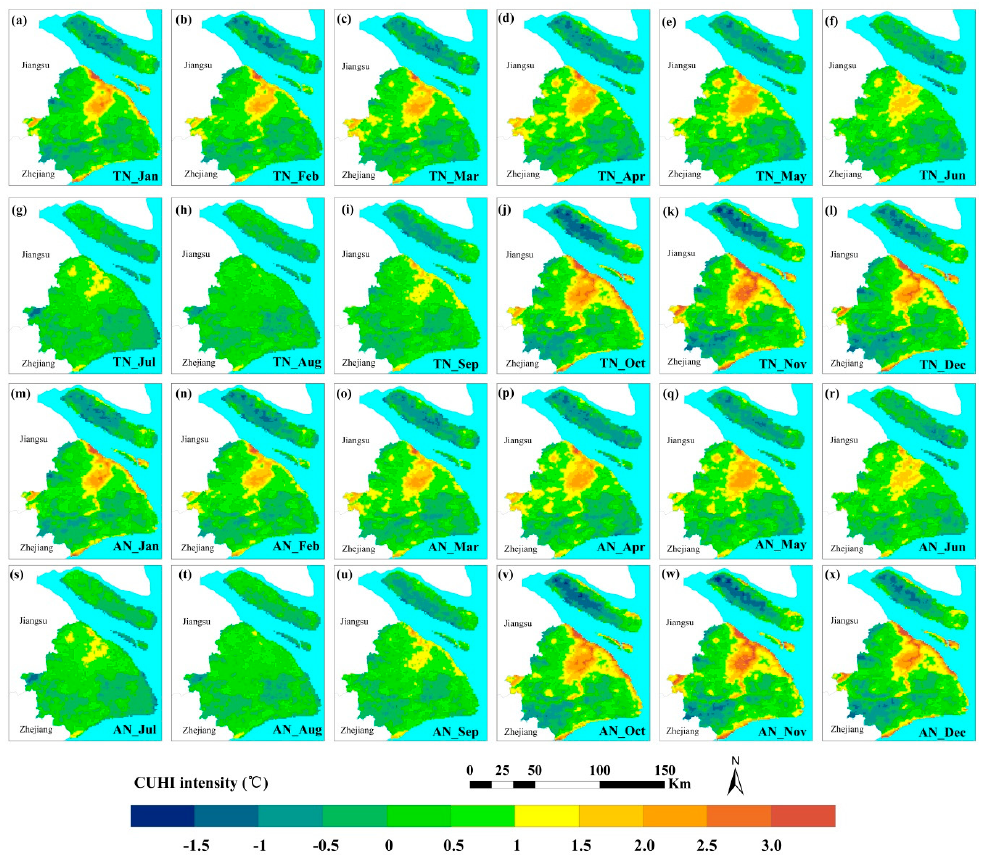
Figure 10 . Climatological maps of monthly mean nighttime CUHI intensity calculated form satellite-estimated air temperature. ( a – l ) each month at the Terra nighttime overpass (TN ~ 22:30) during the period 2000–2013; and ( m – x ) each month at Aqua nighttime overpass (AN ~ 01:30) during the period 2002–2013 over Shanghai.